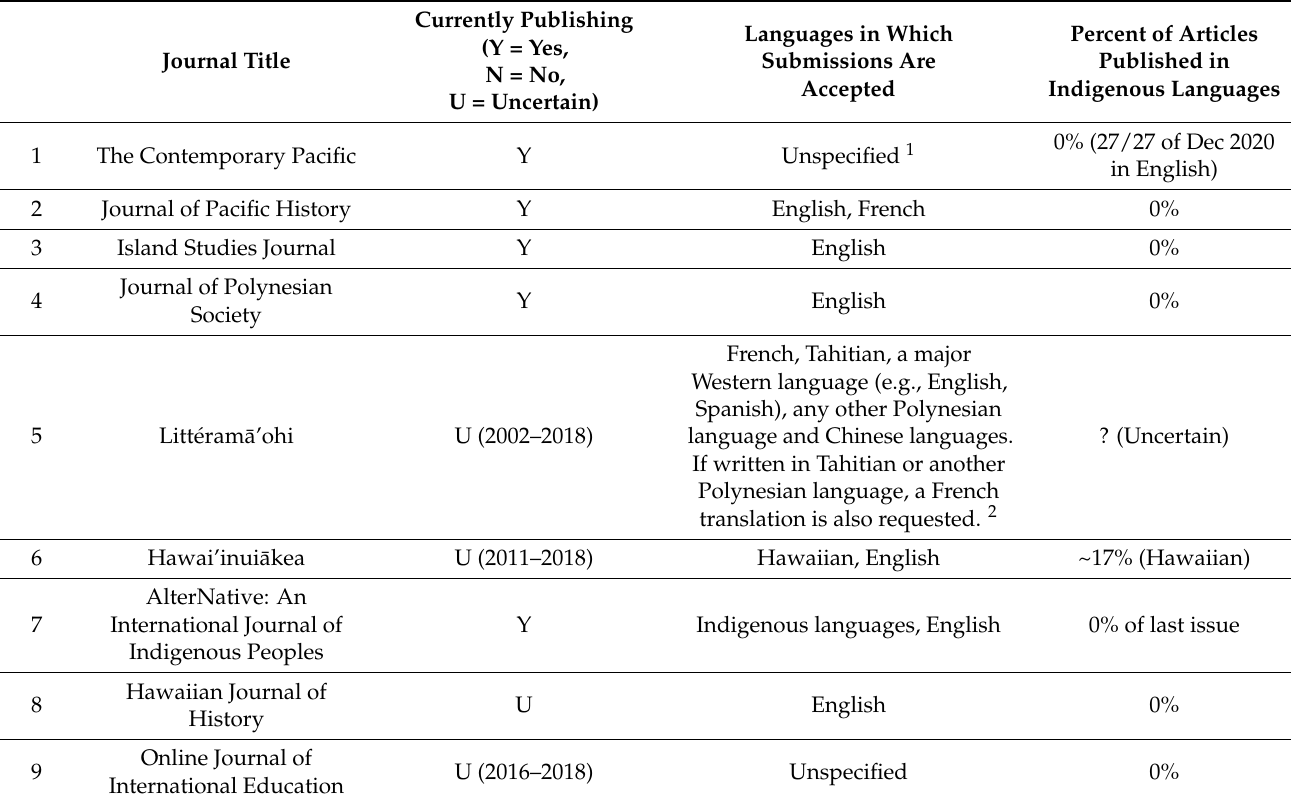
Table 1. Languages of published articles in journals on Pacific Island